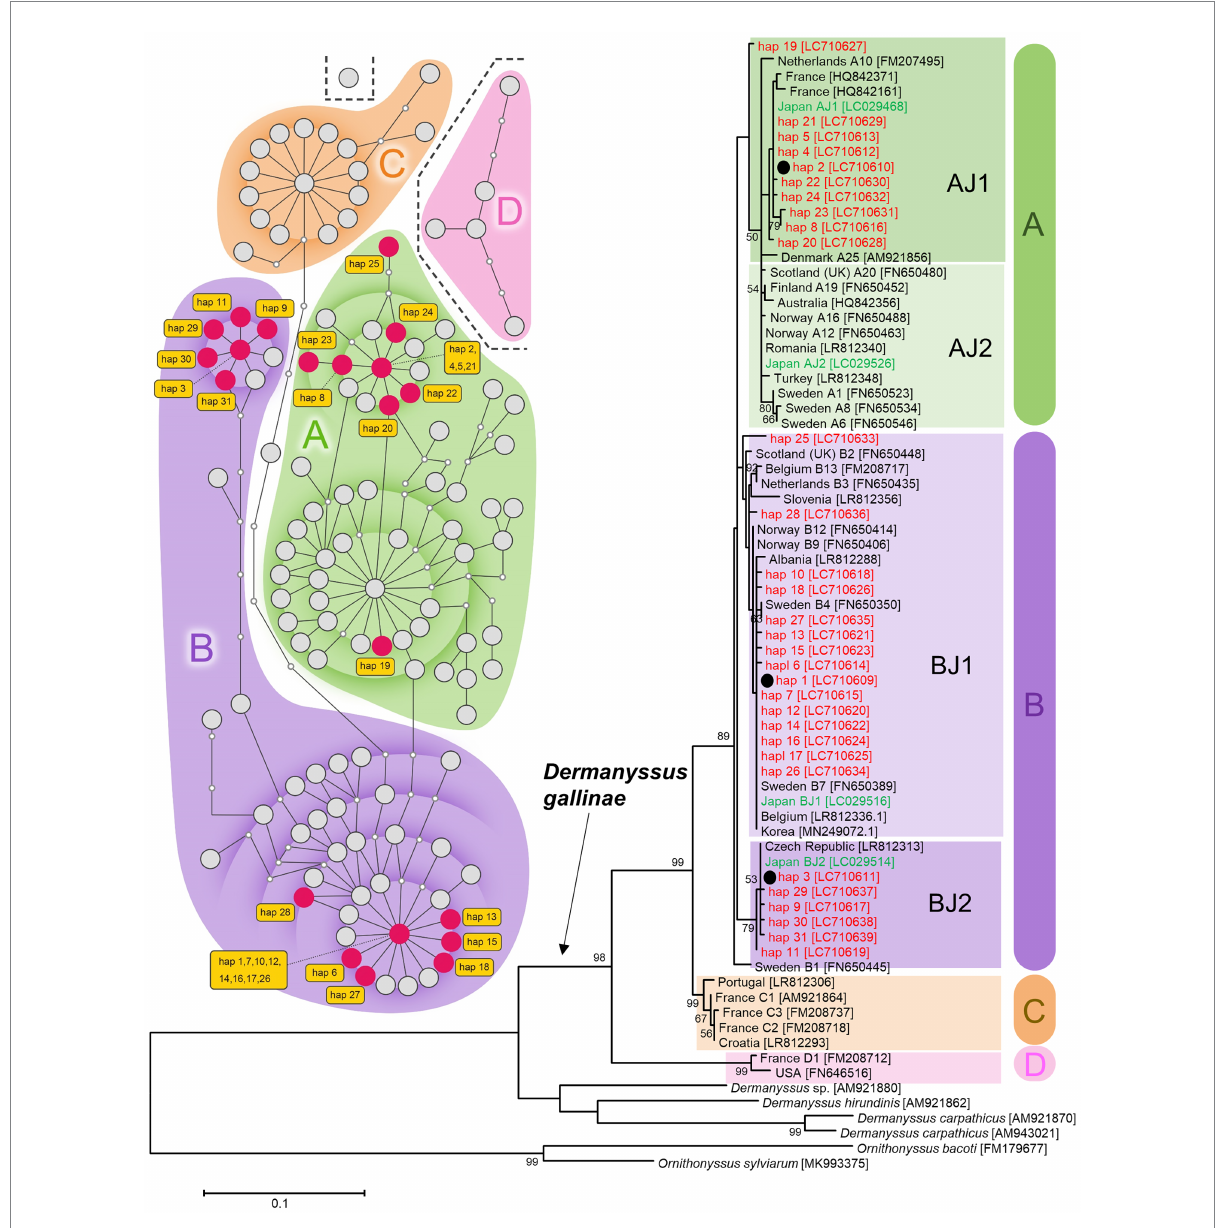
FIGURE 2 Mitochondrial DNA diversity of Japanese D. gallinae examined in this study among global samples of D. gallinae . Left : A TCS haplotype network based on COI sequences (314 bp; 122 OTU) of D. gallinae . Right : A maximum-likelihood phylogenetic tree (model T92 + G) based on COI sequences (469 bp; 75 OTU) of D. gallinae together with three other species of Dermanyssus and two species of Ornithonyssus . Based on the 469-bp sequences, 144 individual mites examined in this study fell into 31 haplotypes (hap 1–hap 31). Haplogroups (A–D) are shaded by respective colors. For the network, existing haplotypes are represented by large circles, and missing haplotypes are represented by small circles which are connected by branches representing 1-bp substitutions. Based on the 314-bp sequences, the 31 haplotypes were assigned into 21 haplotypes (indicated by red circles in the network). For the phylogenetic tree, the three most representative haplotypes (hap 1, hap 2, and hap 3) are indicated with black circles and their bootstrap probability is shown at each node. Nomenclature of haplotypes used in the previous studies (Øines and Brännström, 2011; Chu et al., 2015) are given following the country names. Haplotypes of Japanese samples are shown in red (this study) and green (Chu et al., 2015). Numbers in square brackets indicate accession numbers of NCBI. See Supplementary Table 3 for sample